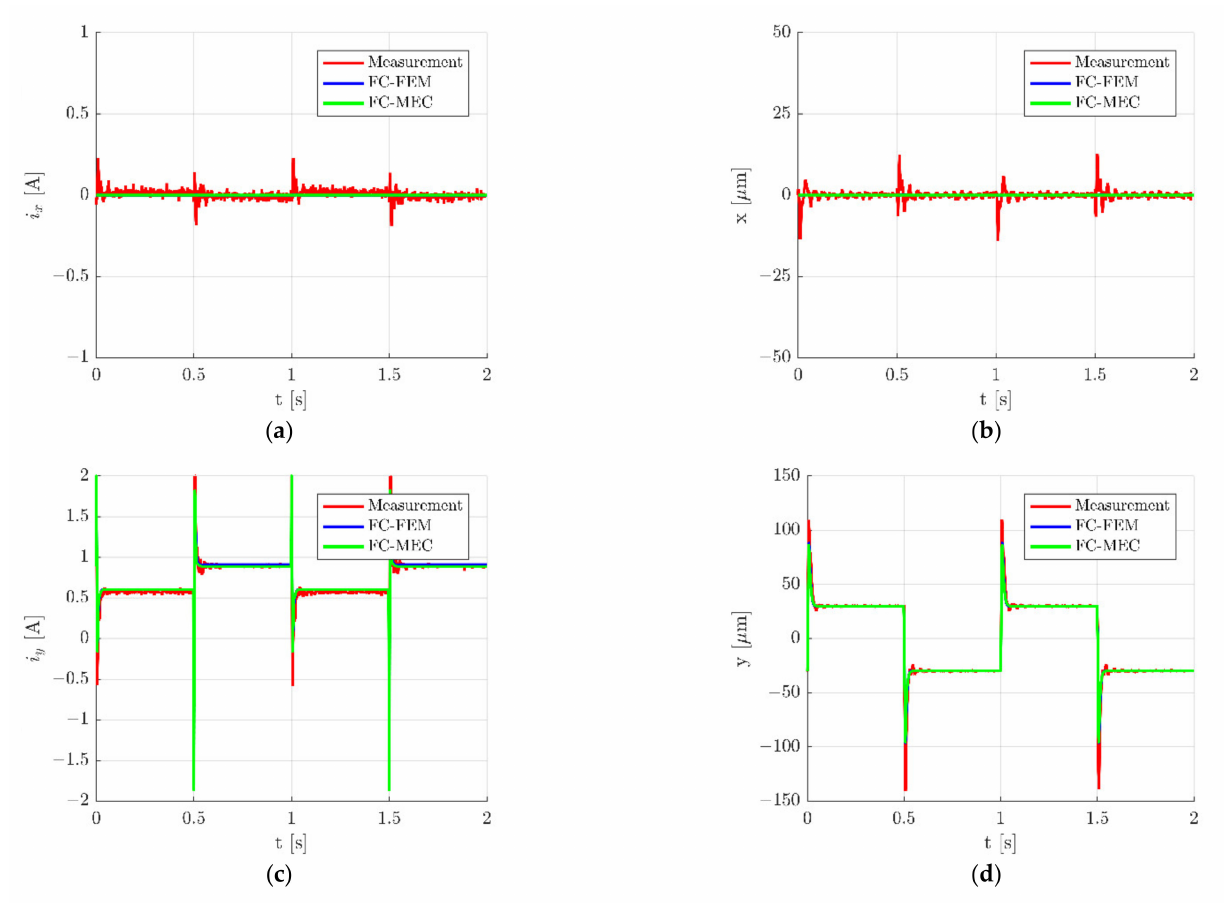
Figure 12. Time responses of the control current i x ( a ), the rotor position x ( b ), the control current i y ( c ) and the rotor position y ( d ) for the step change ± 30 µ m of the rotor position along the y -axis.